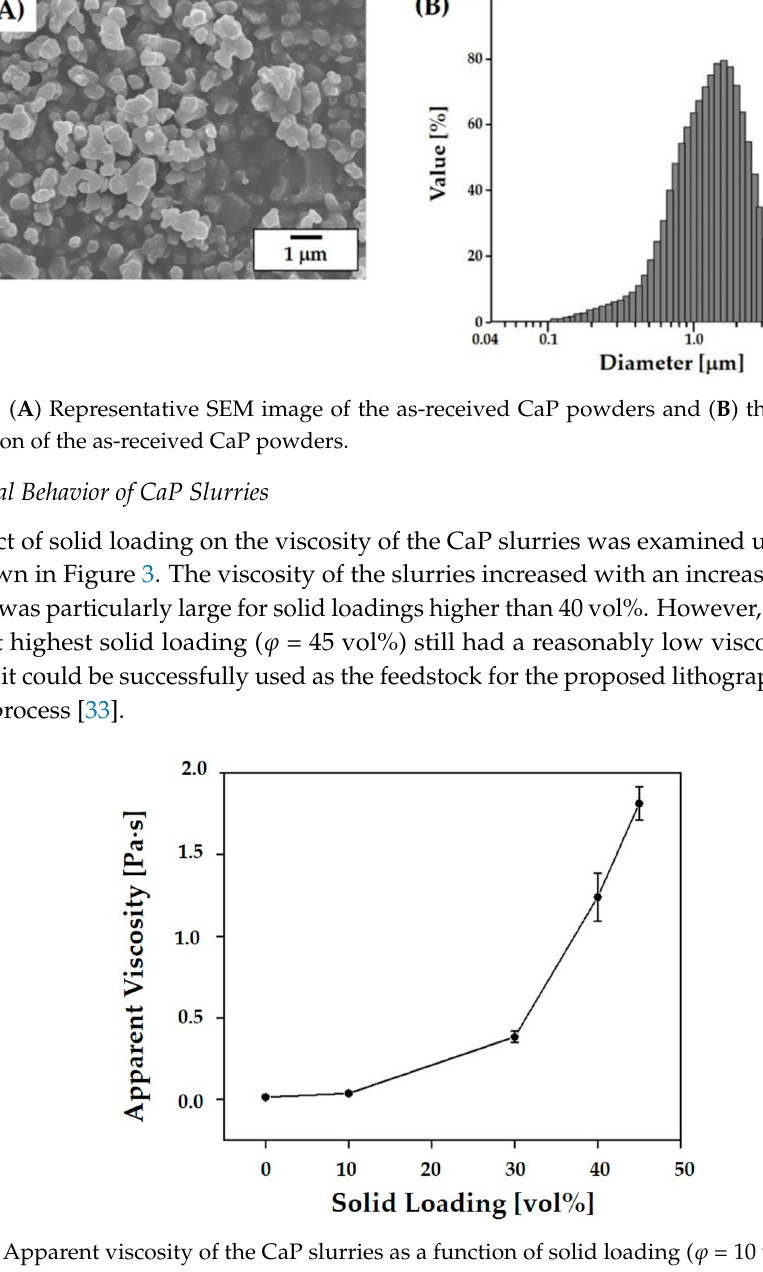
Figure 3. Apparent viscosity of the CaP slurries as a function of solid loading ( φ = 10 vol%, 30 vol%, 40 vol%, and 45 vol%).